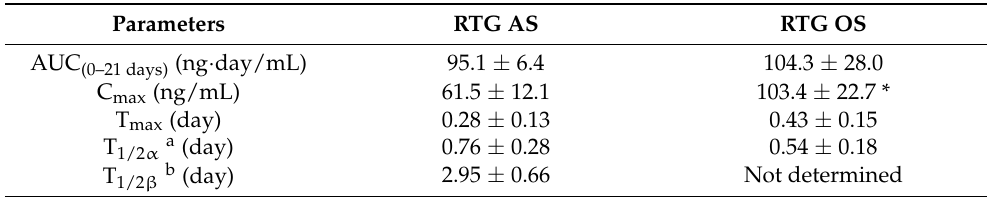
Figure 5. Plasma concentration-time profiles of RTG following SC injection of RTG AS ( ) and RTG OS ( ) in rats (30 mg/kg as RTG). Notes: Data are expressed as mean ± SD ( n = 5). The dashed line (--) indicates the limit of quantitation (LOQ). The plasma concentration of RTG after AS or OS injection was below the LOQ after 28 and 7 days, respectively. Table 4. Pharmacokinetic parameters of RTG following SC injection of drug suspensions in rats (30 mg/kg as RTG).